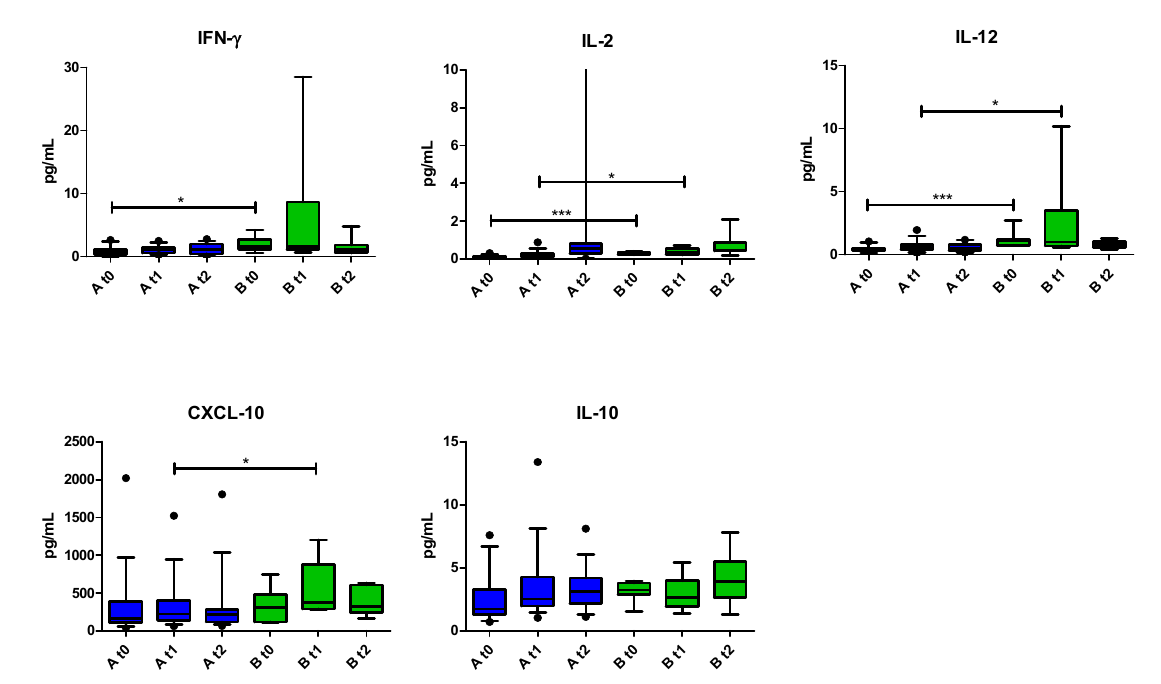
Figure 8. Distributions of five cytokines in group A (blue bars) and B (green bars). Only cytokines with any statistical significance or trend are shown. Concentrations are express in pg/mL. IL-2 for graphical purpose has a value (84.60 pg/mL) at t2 of group A that was intentionally removed by scaling the y-axis. * p ≤ 0.05; *** p ≤ 0.001. Considering the whole population, only the increase of IL-10 over time correlated with a significantly poorer survival (Figure 9).